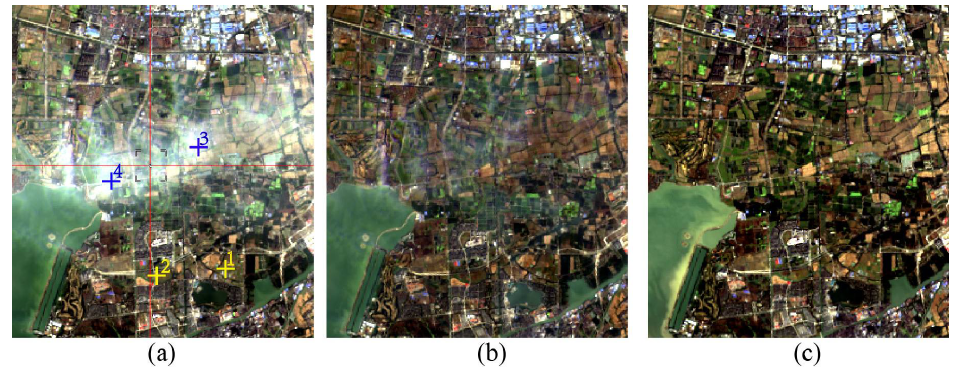
Figure 16. Comparison of dehazing result and haze-free image: ( a ) hazy image (path: 119, row: 038, acquisition date: 1 January 2016); ( b ) dehazed image using MODEL-T; ( c ) haze-free image (path: 119, row: 038, acquisition date: 16 December 2015).